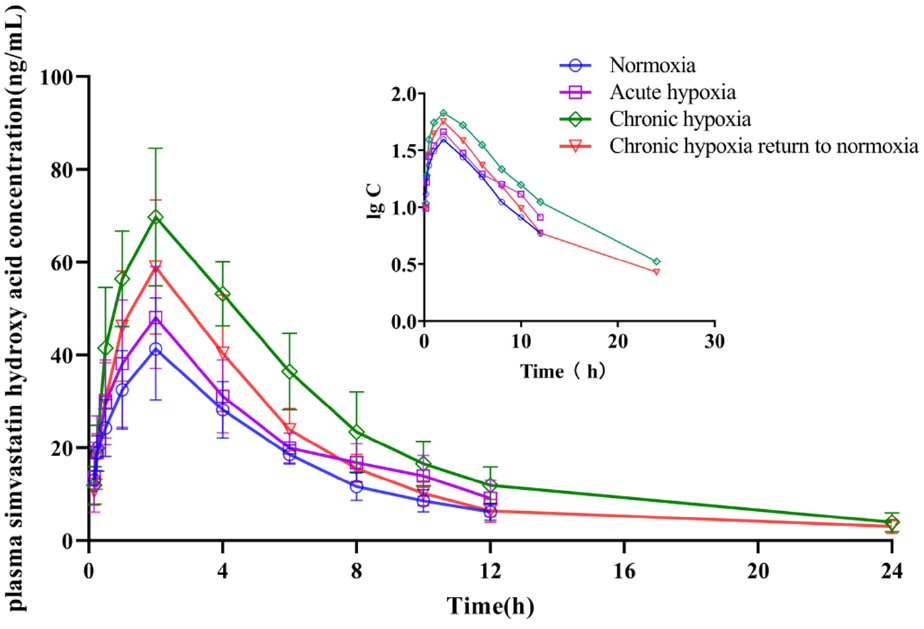
Figure 5. Mean plasma concentration time curve of simvastatin hydroxy acid for rats after exposure to high-altitude hypoxia ( n = 8).